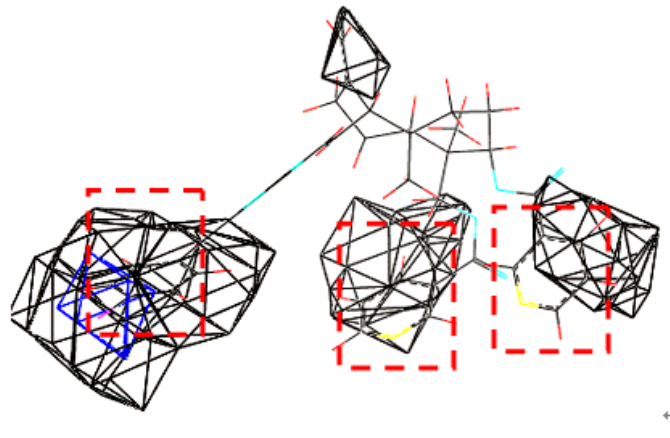
Figure 8. Compound 21 was placed in the steric contour